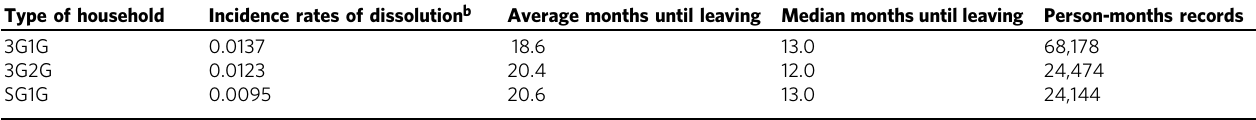
Table 2 Descriptive statistics on dissolutions over survey period a , by focal generation heading the household. Type of household